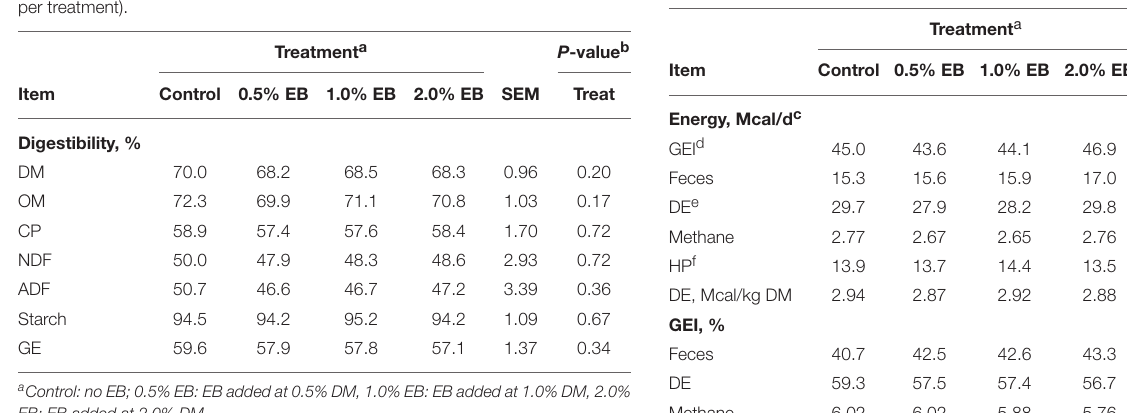
TABLE 5 | Apparent total tract nutrient digestibility of beef heifers fed a barley silage-based diet containing increasing addition of enhanced biochar (EB; n = 8 per treatment).